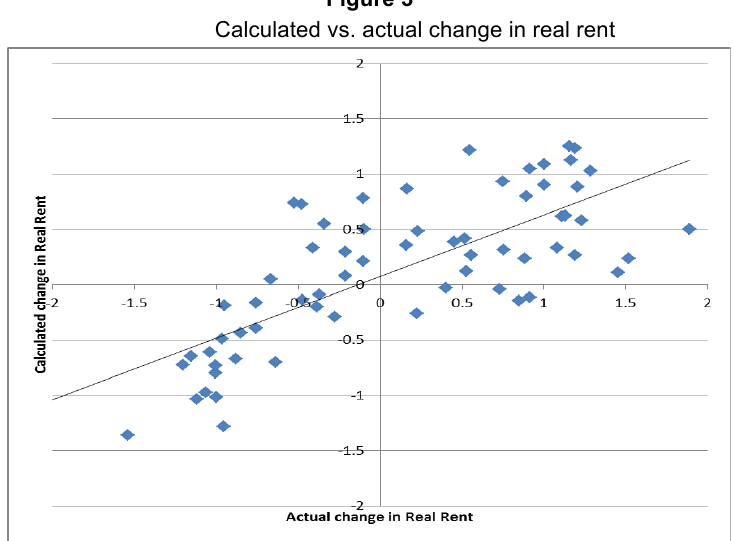
Calculated vs. actual change in real